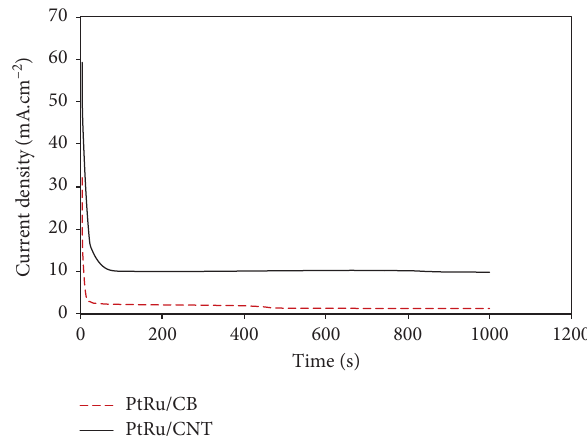
Figure 7: Chronoamperometry test of synthesized samples.